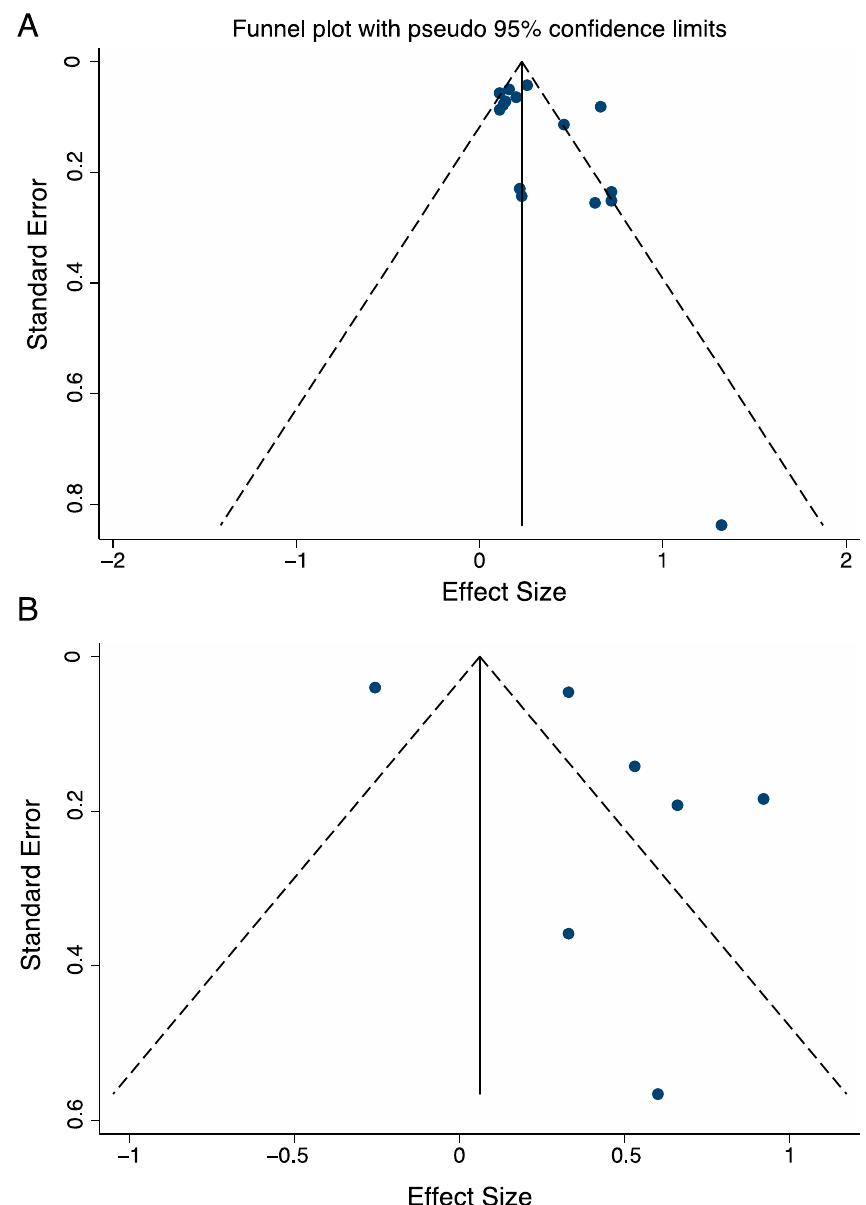
Figure 7. Funnel plots used to examine publication bias in dual task—single task differences in PFC activation in healthy adults ( A ) and in adults with neurological diseases ( B ).